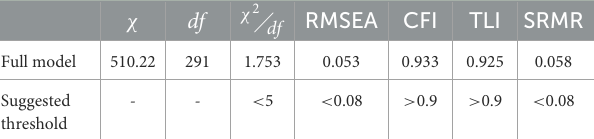
TABLE 4 Fit indices of the full model. TABLE 5 Summary of mediation